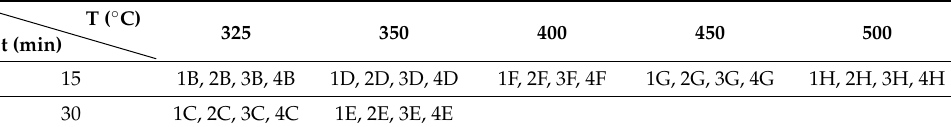
Table 1. Summary of the combinations of annealing temperature and time used to process the samples and description of the corresponding labels which were associated to the samples after the annealing processes.